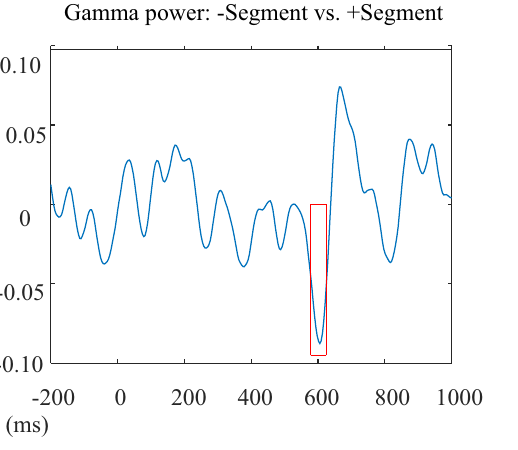
Figure 2. Results of time-frequency analyses for the effect of Segment in the English experiment. Gamma frequency range of the contrast + Segment minus − Segment in the C1 electrode (left); the topography of gamma frequency range from 578 to 633 ms with the white star marking the location of the C1 electrode (right). The colour scale indicates the relative power changes (0 = no